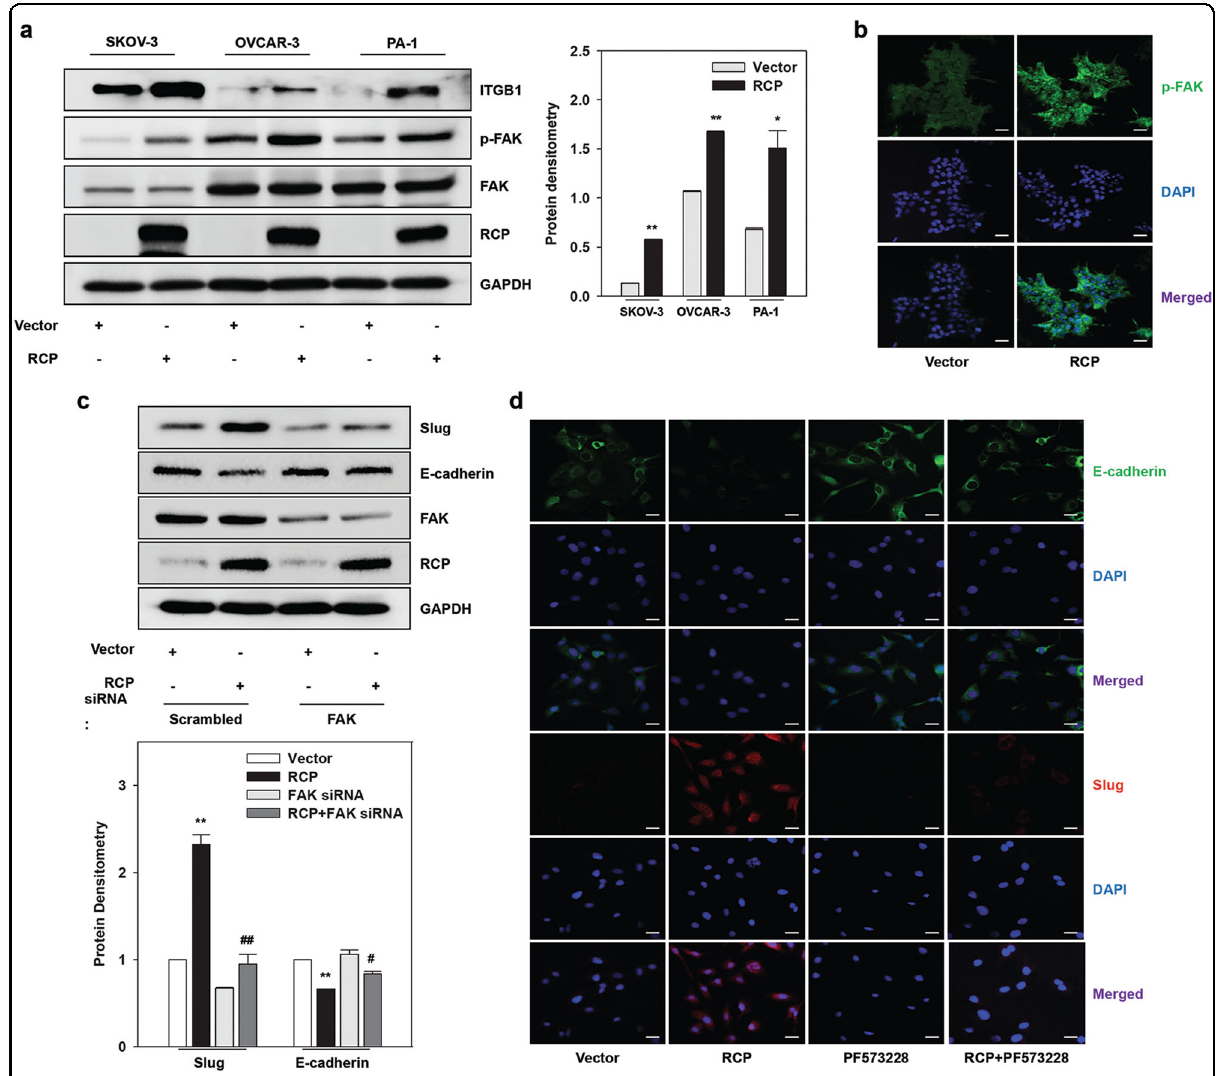
* P < 0.05, ** P < 0.01 vs. the control vector). b PA-1 cells were transfected with the indicated vectors, and the expression of FAK phosphorylation was visualized by immuno fl uorescence. Original magni fi cation, ×200; scale bar, 20 μ m. Representative results are presented from at least